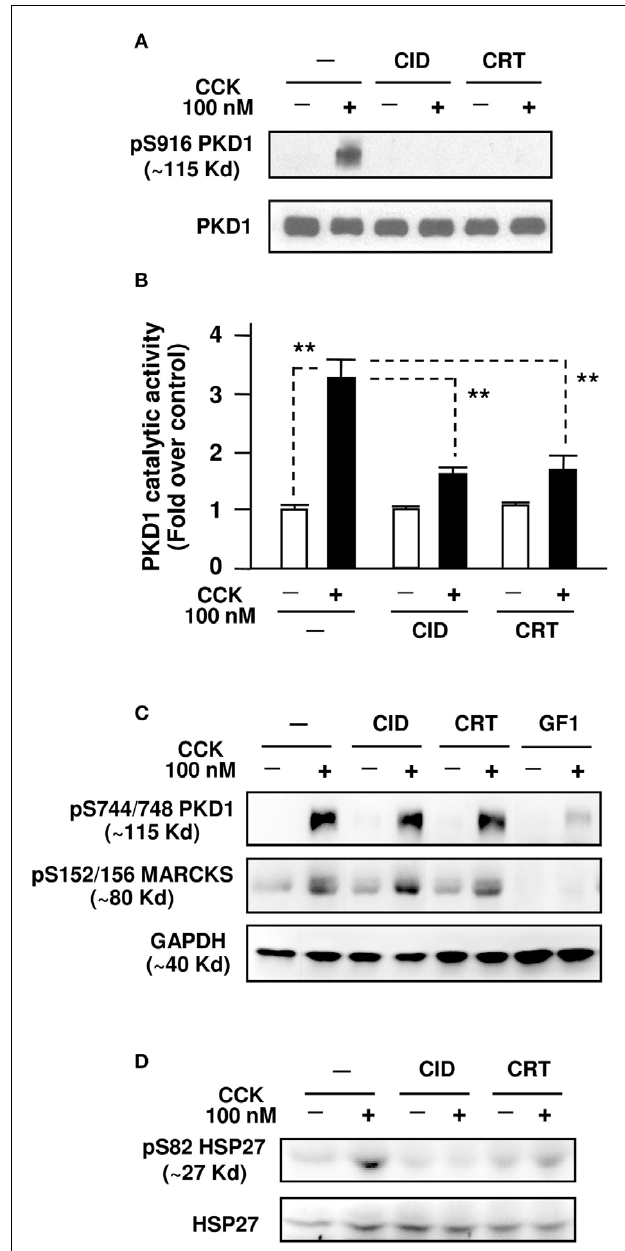
FIGURE 1 | CID755673 and CRT0066101 selectively inhibit supramaximal dose CCK-induced PKD/PKD1 activation in pancreatic acinar cells. Isolated pancreatic acini were pre-incubated for 3h with CID755673 (CID), CRT0066101 (CRT), or GF 109203X (GF1), followed by incubation with 100nM CCK for 30min.The acini were collected and lysed. (A) PKD/PKD1 autophosphorylation at its Ser916 (pS916 PKD1) was determined byWestern blot analysis of the acinar lysates using anti-phospho-Ser916 PKD/PKD1 antibody, as described in Section “Experimental Procedures.” Blots were stripped and re-probed with PKD1 C-20 antibody for loading control. Shown are representative blots from at least three independent experiments. (B) PKD/PKD1 was immunoprecipitated from the acini lysate with PKD1 C-20 antibody and the PKD/PKD1 catalytic activity was measured with in vitro kinase assay as